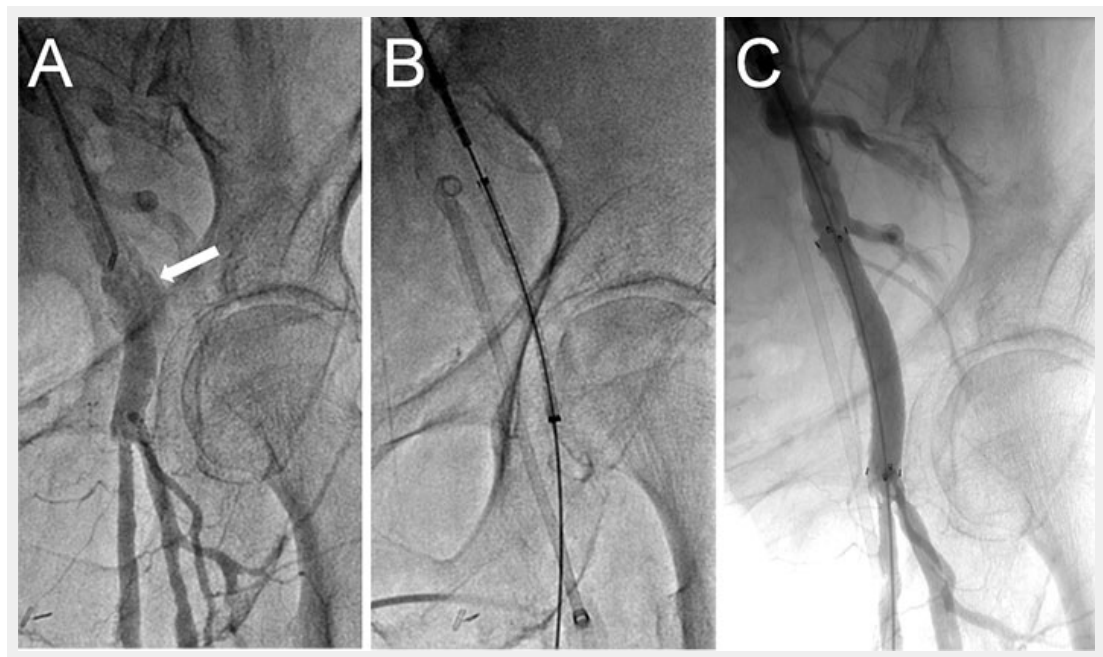
Figure 7 Treatment of femoral artery injury by a covered stent. This patient presented with acute haemorrhage of the femoral artery (A). Bleeding was controlled by balloon tamponade, after which a Fluency Plus 9 x 60 mm covered self-expanding stentgraft (Bard Canada Inc., Oakville, Canada) was implanted with a good result (B,